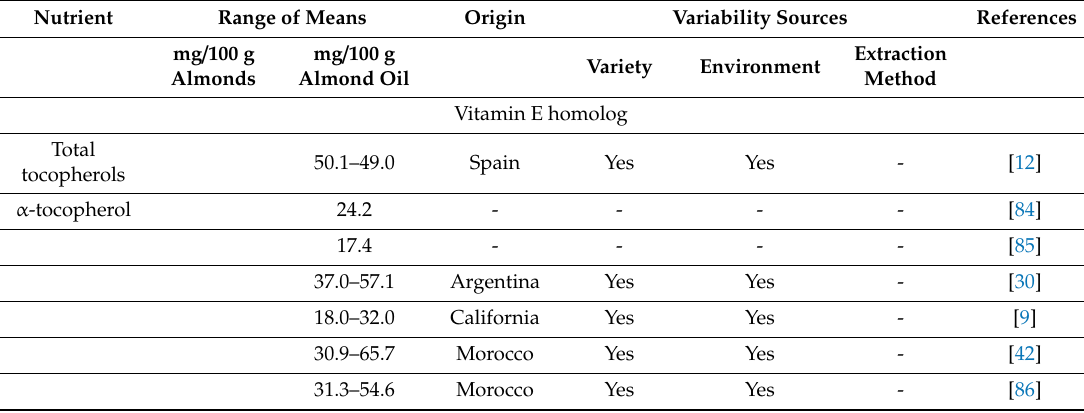
Table 3. Vitamin content in